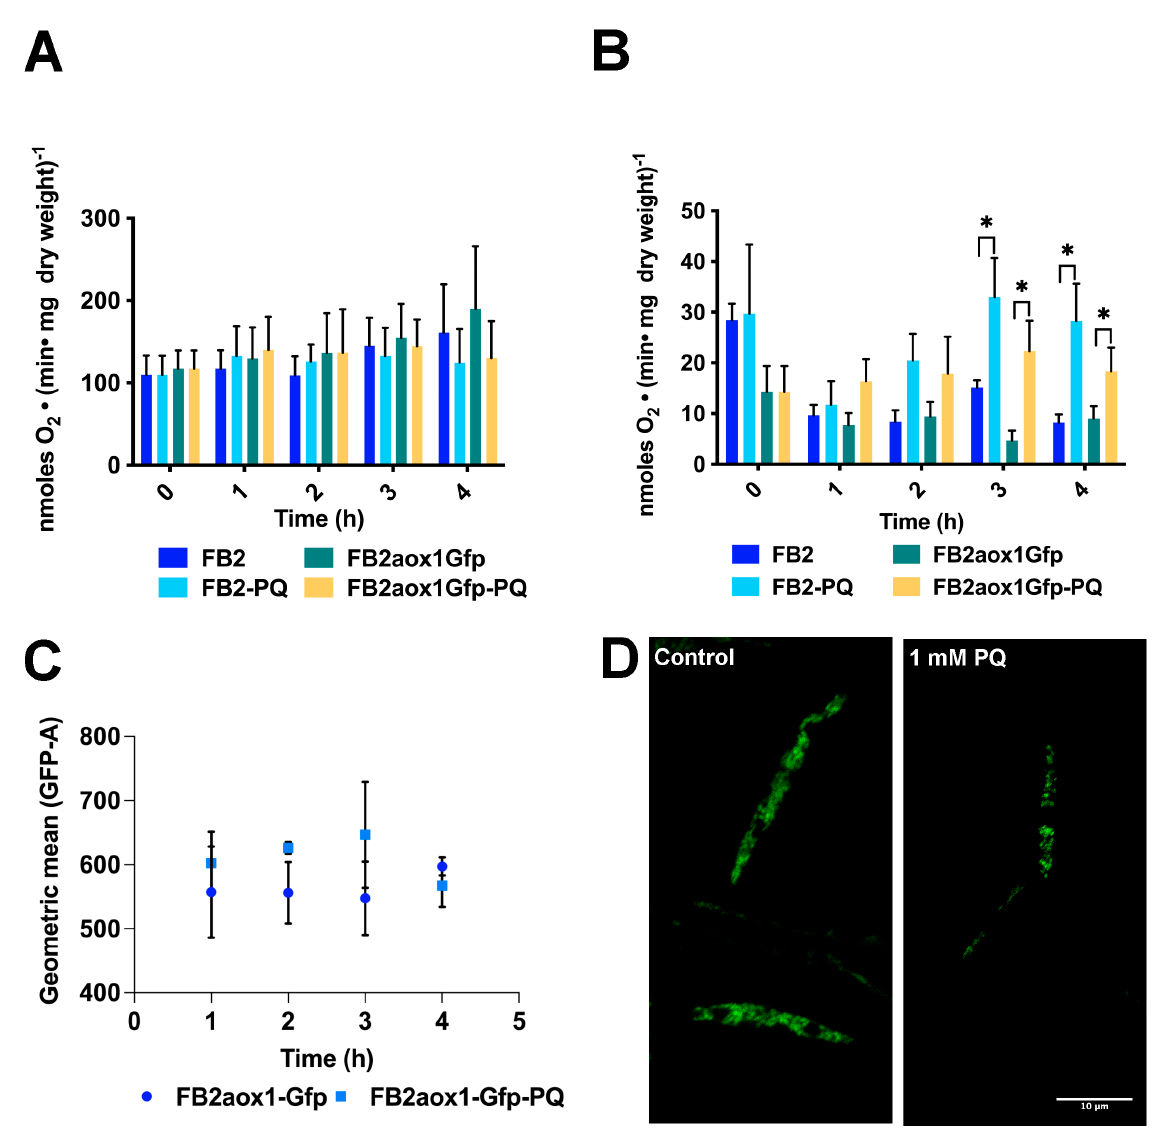
Figure 2. Effect of PQ on the activity and amount of U. maydis Aox1. A cellular suspension with an initial OD 600 nm of 5 was incubated for 4 h in the presence or absence of 1 mM PQ. At the indicated times, cells were harvested and resuspended in water (1 mL H 2 O:1 g wet weight). Oxygen consumption was analyzed with a Clark-type electrode in the absence ( A ) or presence ( B ) of 1.5 mM cyanide, an inhibitor of the cytochrome pathway. ( C ) Changes in Aox1 expression were determined by measuring the fluorescence of the Aox1-Gfp. Samples were withdrawn at the indicated times, and the fluorescence was determined by flow cytometry in 20,000 events per condition. ( D ) The changes in fluorescence were corroborated by confocal microscopy. A one-way ANOVA was performed to detect significant differences among the means. * Significant difference at p < 0.05. The data correspond to an average of four independent experiments ( n = 4) with bars indicating the standard